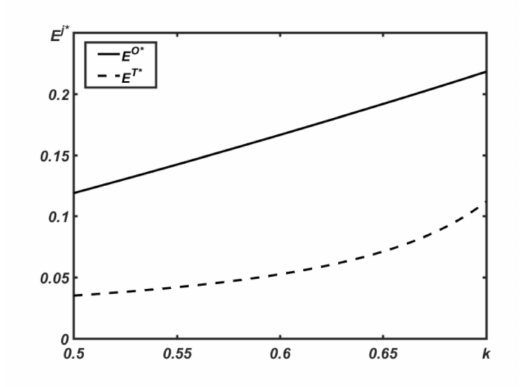
Figure 6. Variations of E j ∗ .